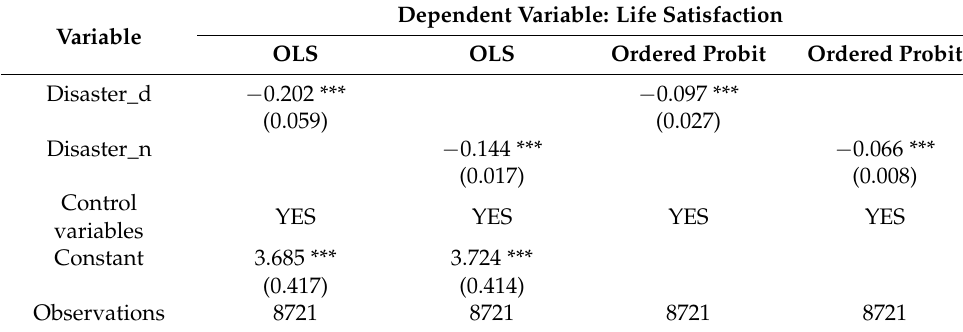
Table 9. Natural disasters and happiness.